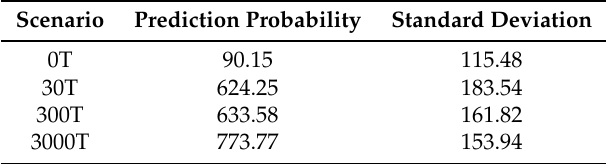
Table 2. Approximation of area under the graph for the different scenarios for both prediction and standard deviation.